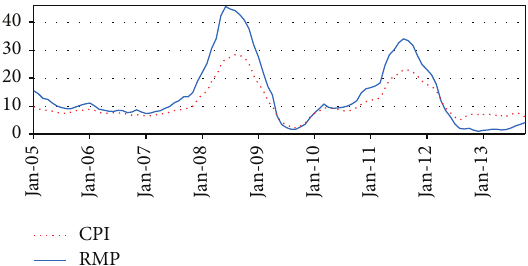
Figure 3: Raw Material Prices (%). Note: this figure shows the evolution of the year-on-year growth rates of overall CPI and of the average of the 108 Raw Material Price (RMP) series. All of the series are standardized.